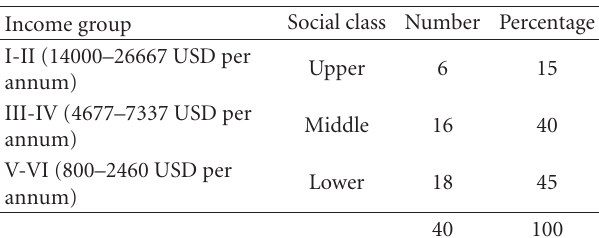
Table 2: Annual income data for a cohort of 40